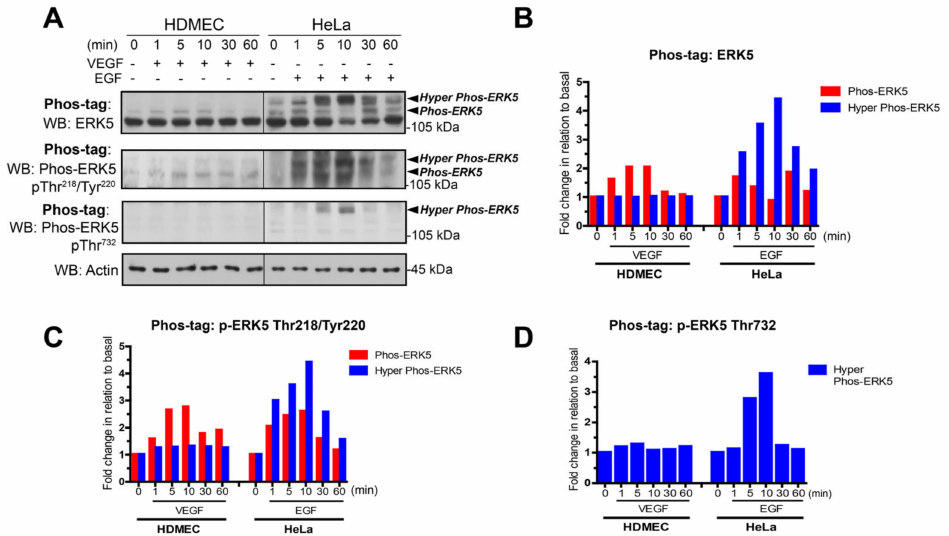
Figure 2. VEGF does not stimulate C-terminal phosphorylation of ERK5 in HDMECs. ( A ) HDMECs and HeLa cells were serum-starved overnight prior to stimulation for various time periods with either VEGF (50 ng/mL) or EGF (50 ng/mL), respectively. Cells were lysed in RIPA buffer and lysates were resolved by Phos-tag SDS-PAGE and analysed for ERK5 activation using site-specific phospho-antibodies. Protein loading was confirmed by blotting for Actin. ( B ) Quantification of ERK5 level by densitometric analysis. Data are shown as mean normalised to Actin level ( n = 2). ( C ) Quantification of phospho-ERK5 (T218/Tyr220) level by densitometric analysis. Data are shown as mean normalised to Actin level ( n = 2). ( D ) Quantification of phospho-ERK5 (Thr732) level by densitometric analysis. Data are shown as mean normalised to Actin level ( n =